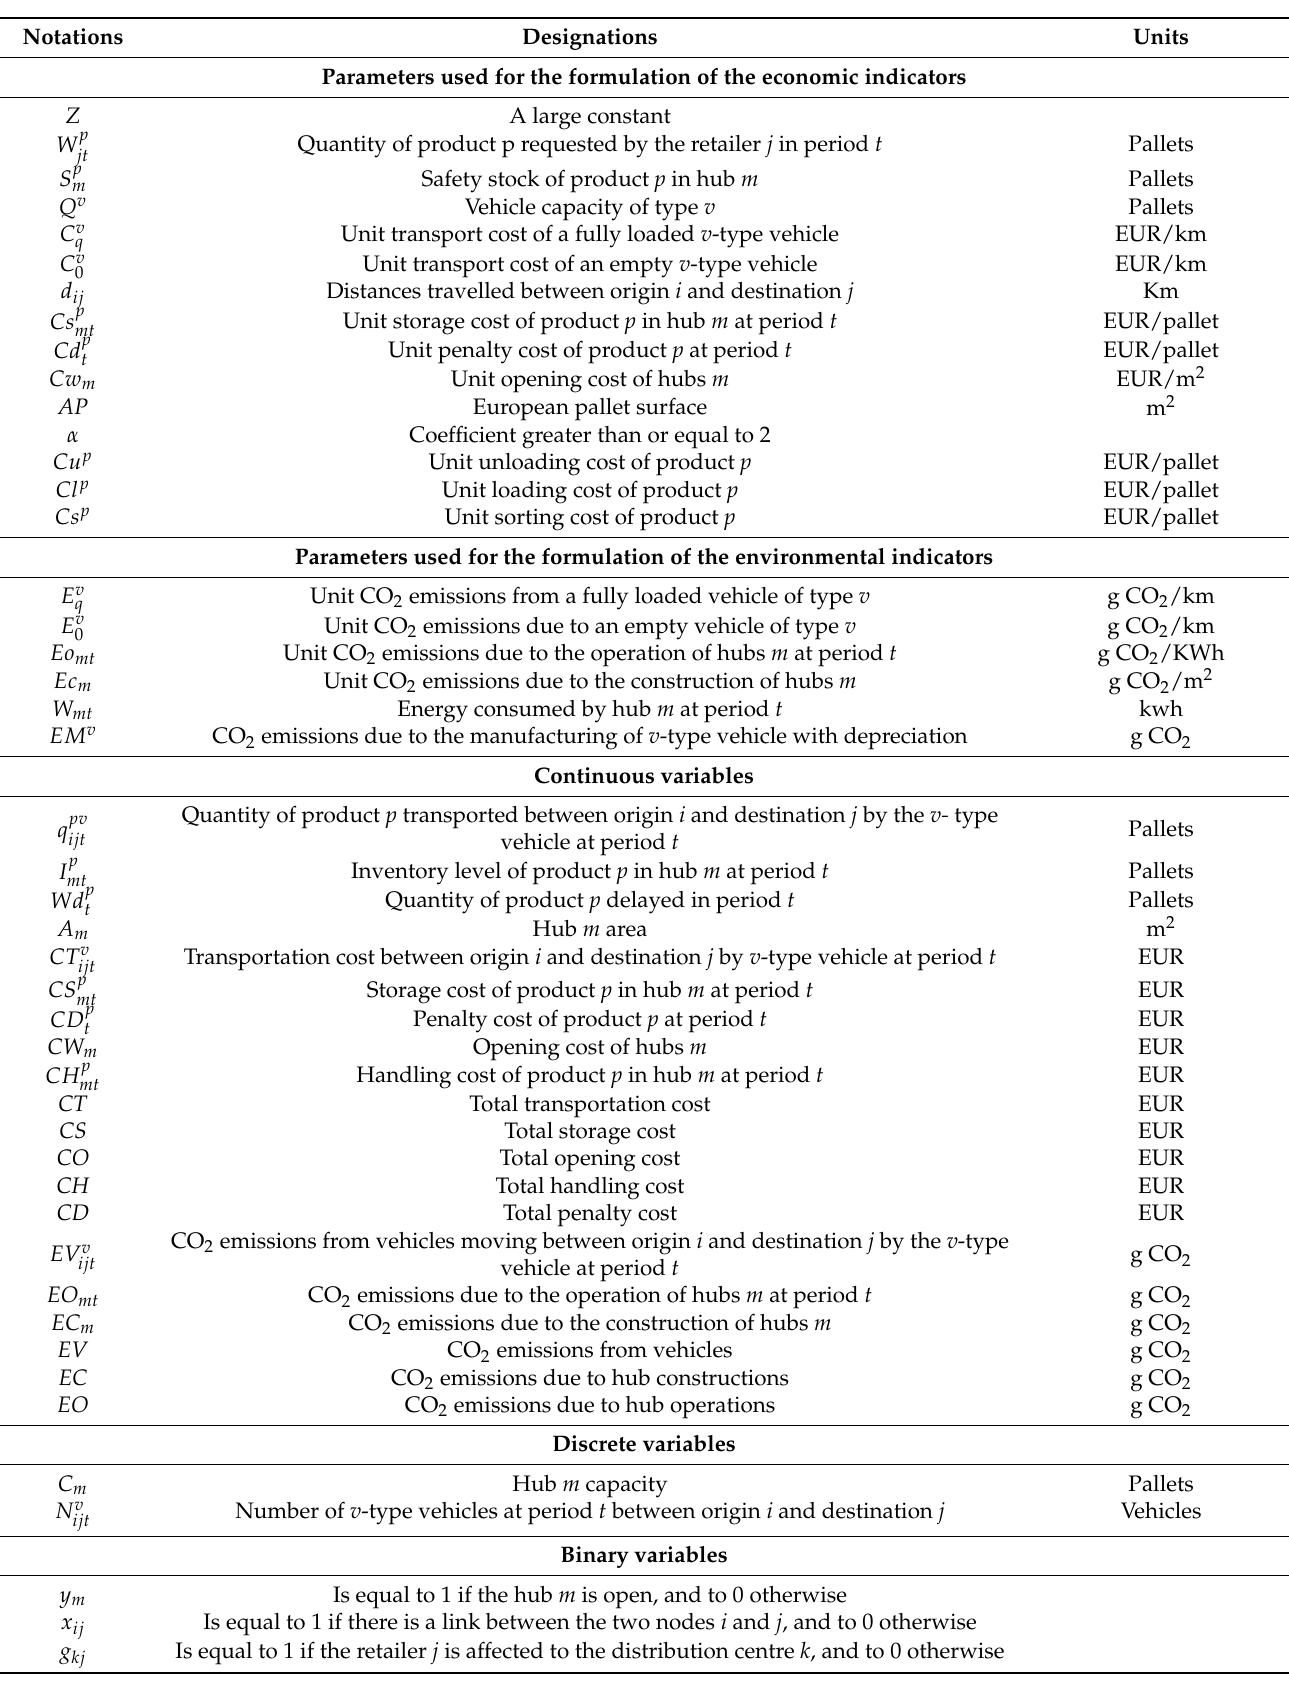
Table 2. The used parameters as well as the binary and continuous